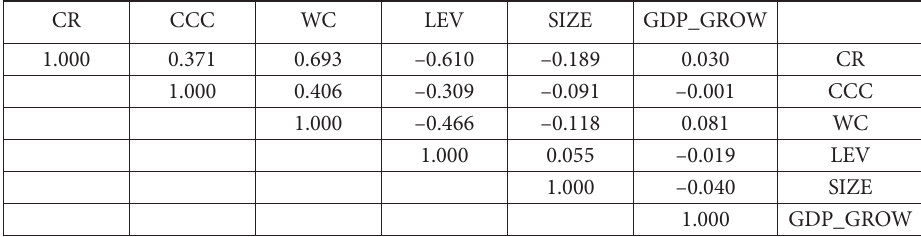
Table 4. Pearson correlation matrix for explanatory variables (critical value = 0.0362) (source: own elaboration) CR CCC WC